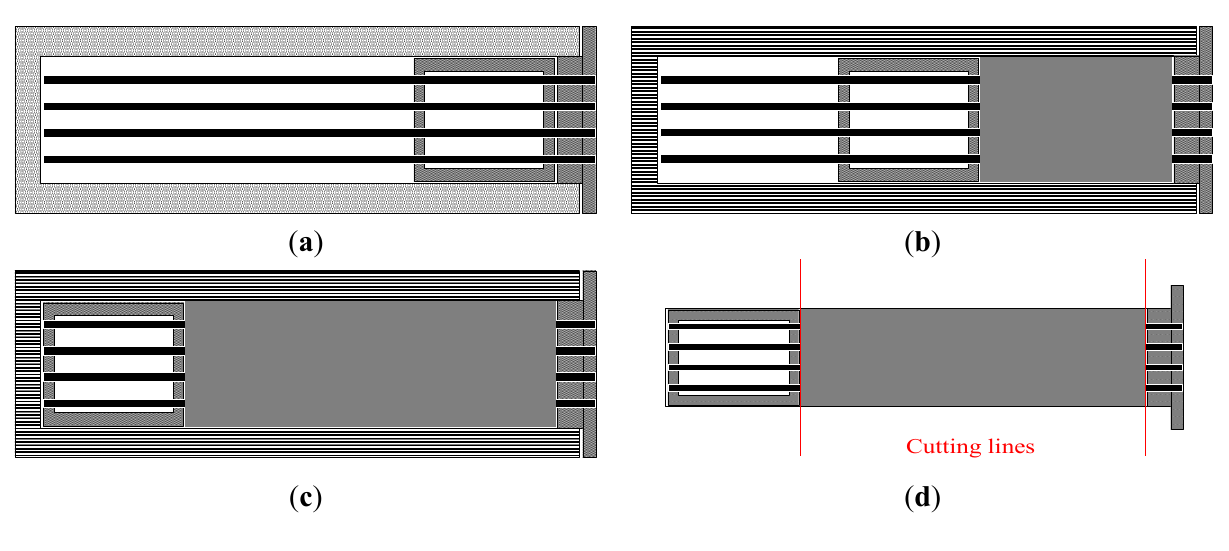
Figure 5. Pictures of the mask and the sliding